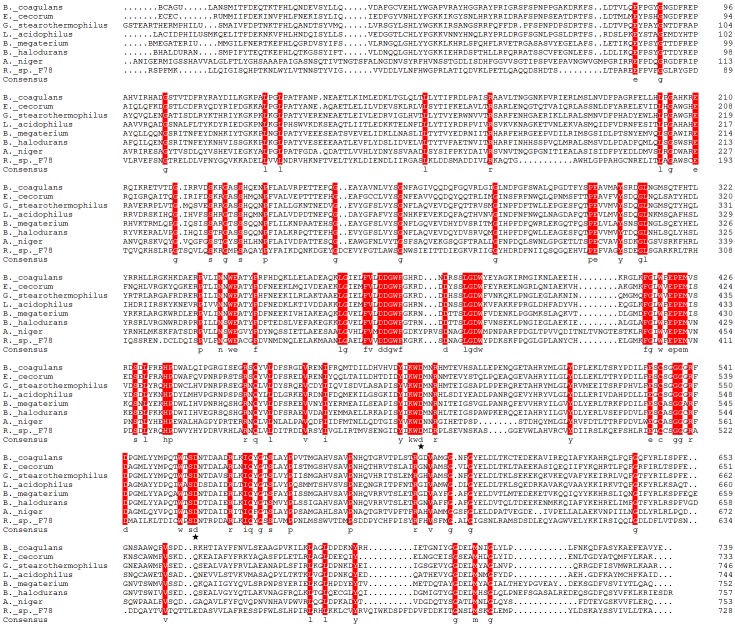
Amino acid sequence alignment of Aga-BC7050 with other glycoside hydrolase (GH) family 36 α-galactosidases.The sequences are indicated with their genus initials, including Enterococcus cecorum, Geobacillus stearothermophilus, Lactobacillus acidophilus, Bacillus megaterium, Bacillus halodurans, Aspergillus niger, and Rhizopus sp. The gaps are indicated by hyphens. Similar or identical amino acid residues at the same position are highlighted. The asterisks show putative catalytic residues.